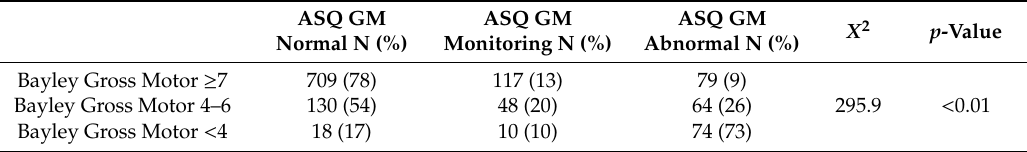
Table 4. Comparison of Bayley-III Gross Motor subscale and ASQ Gross Motor (GM).